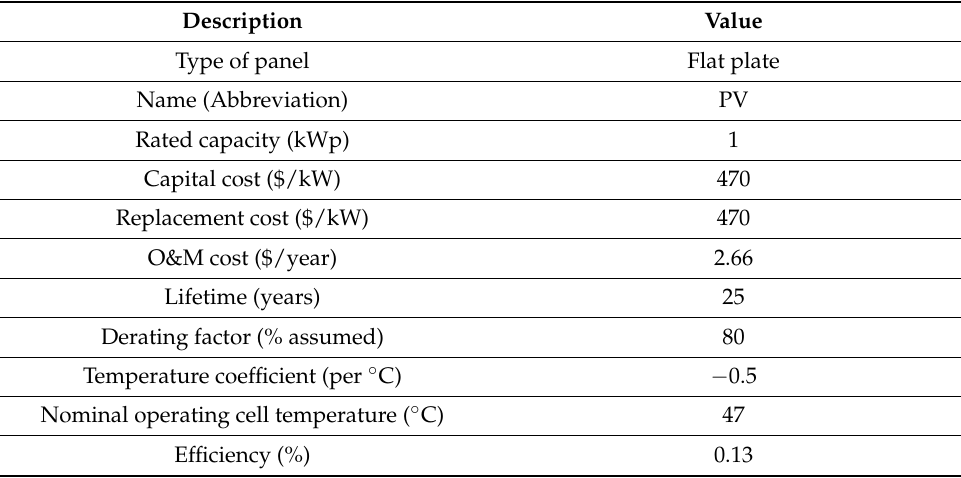
Figure 10. Block diagram of the solar PV array system. Table 2. Specifications of the polycrystalline PV array.